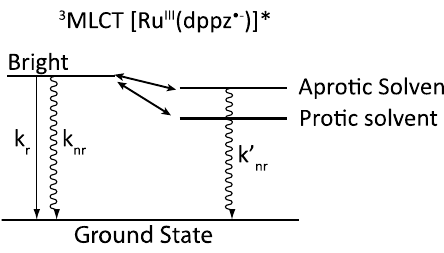
Figure 6. Solvent influence on the dark and bright states.